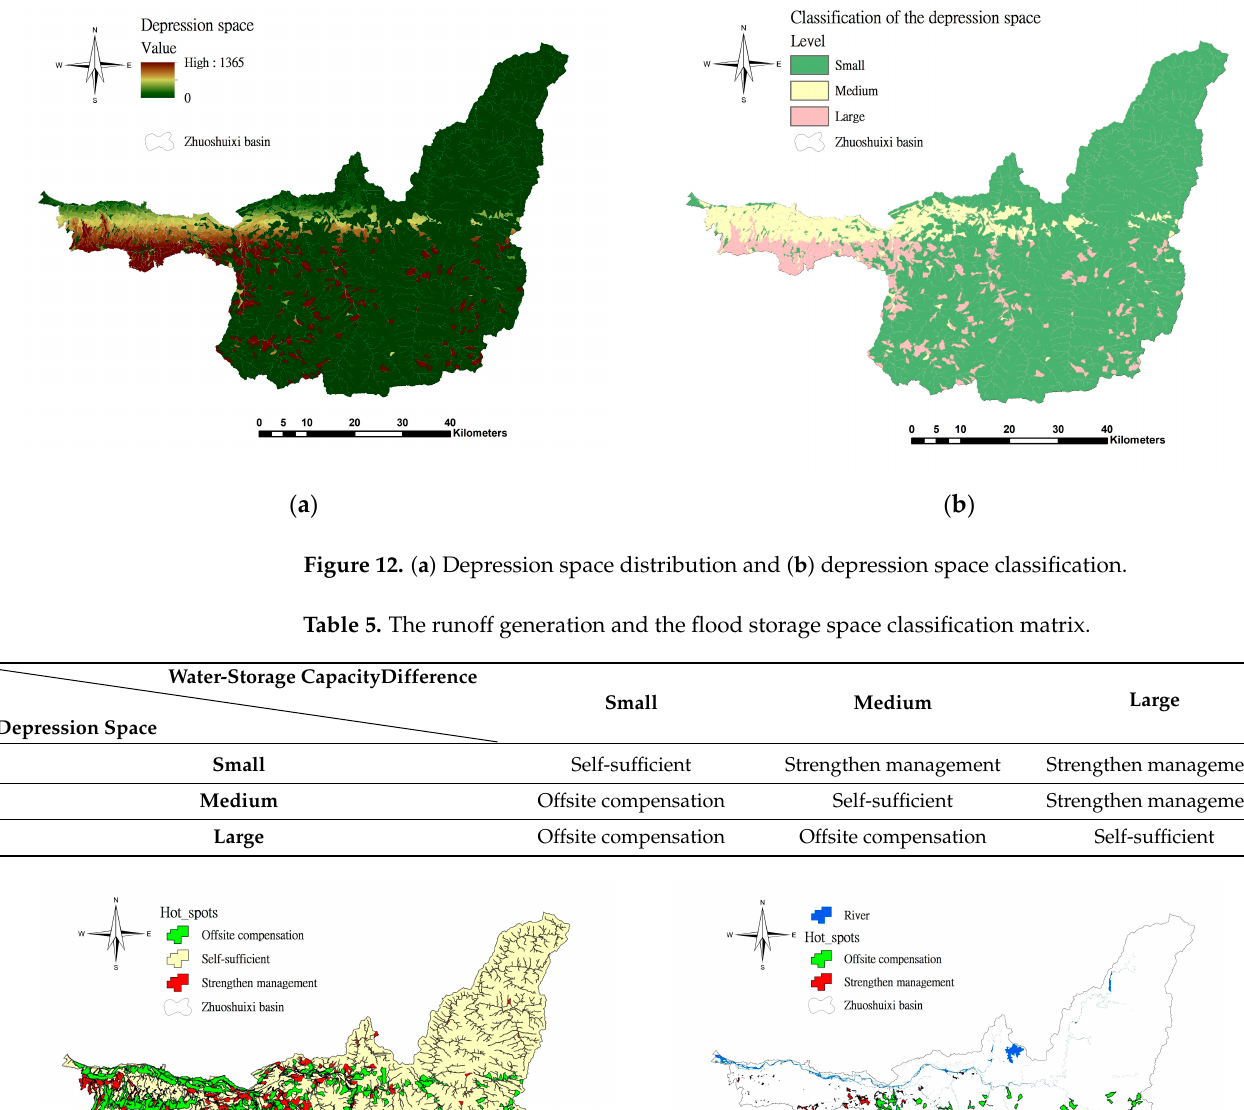
( b ) Figure 11. ( a ) Distribution of the water storage capacity difference and ( b ) distribution of water- storage capacity difference classification.